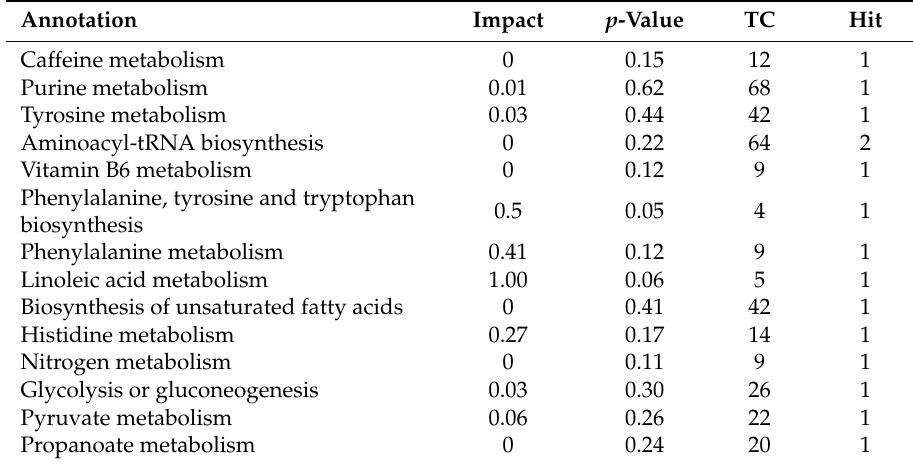
Table 2. Metabolic pathway analysis of the differential